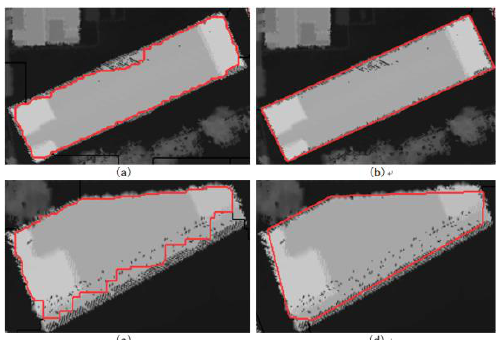
Figure 6. Building contour regularization result. (a) and (b) are rectangle building areas before and after regularization, (c) and (d) are non-rectangular building areas before and after